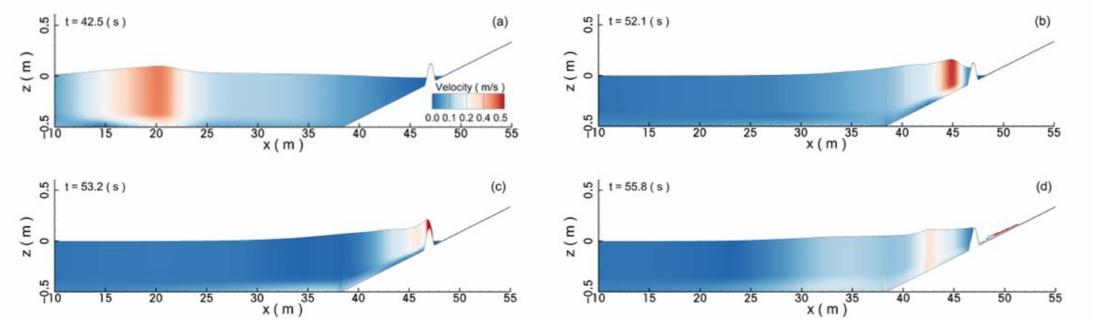
Figure 13. Snapshots of the velocity contours of the water body at different time instances;